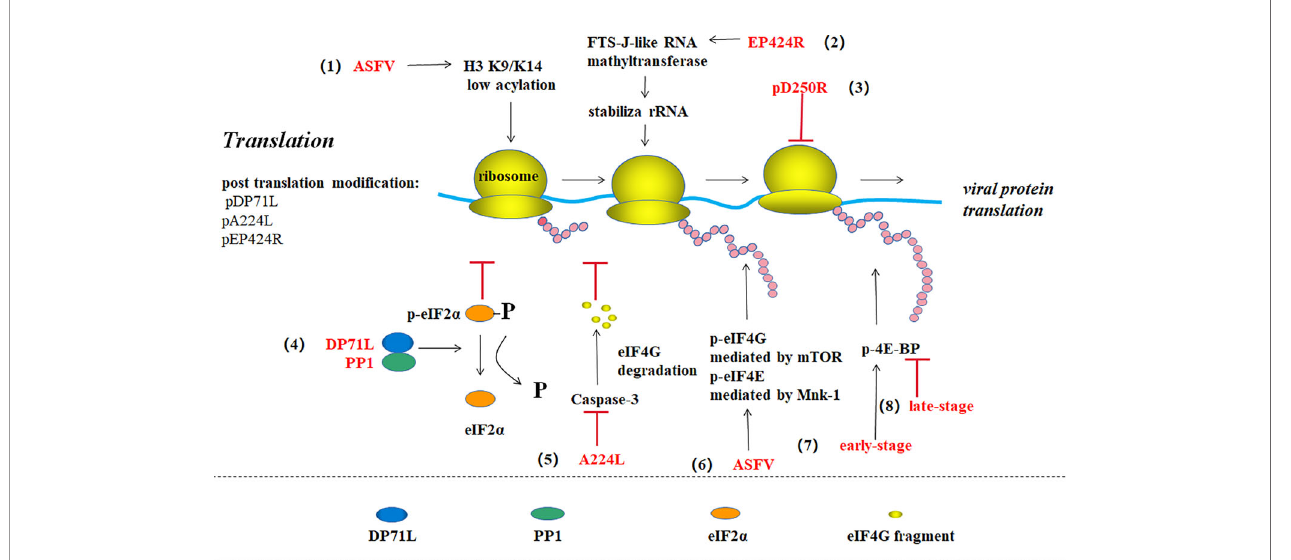
FIGURE 5 | ASFV translation and post-translational modi fi cation (39). (1) ASFV promotes viral gene expression by maintaining the host histone H3 K9/K14 in a low acylation state. (2) EP424R-encoded FTS-J-like RNA methyl transferase may stabilize rRNA in cells and prevent protein synthesis shut down. (3) pD250R inhibits viral translation by reducing the number of transcripts. (4) The virus protein DP71L binds to host phosphatase 1 (PP1) to form eIF2 alpha dephosphorylation, thus enhancing viral protein synthesis. (5) ASFV IAP homologous protein A224L inhibits the Caspase-3-mediated eIF4G degradation to promote translation. (6) ASFV promotes mTOR-mediated eIF4G phosphorylation and Mnk-1-mediated eIF4E phosphorylation to enhance protein synthesis. (7) ASFV promotes 4E-BP phosphorylation and viral protein translation in the early stage of infection, while (8) promotes 4E-BP dephosphorylation in the late stage to inhibit